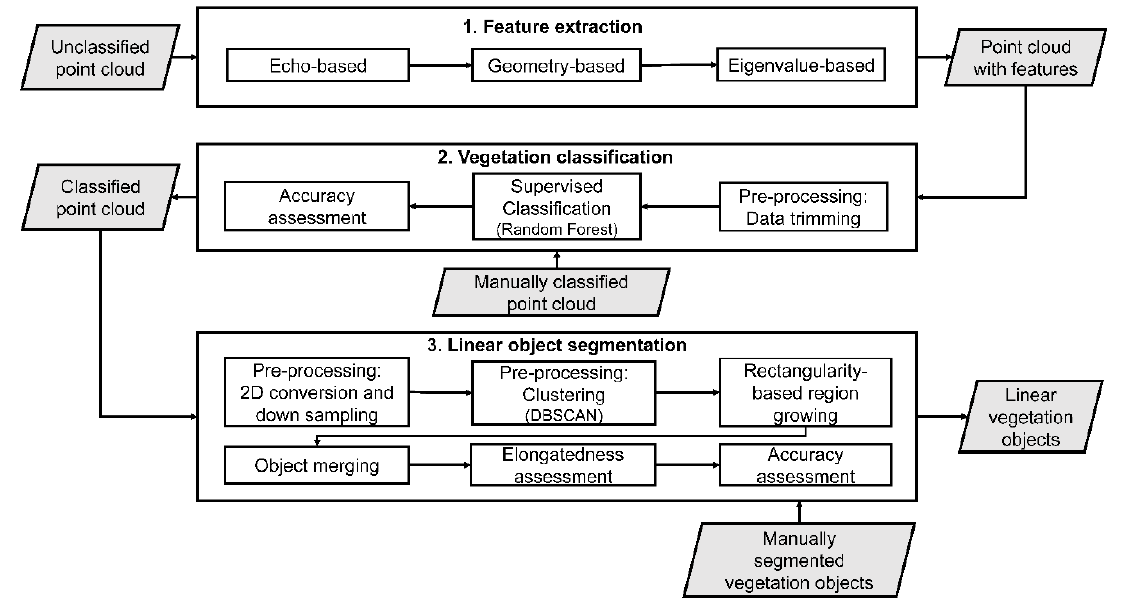
Figure 2. Workflow detailing three routines for the identification of linear vegetation objects, 1. Feature extraction 2. Vegetation classification, and 3. Linear object segmentation. The computational steps are represented as rectangles and datasets as grey parallelograms.